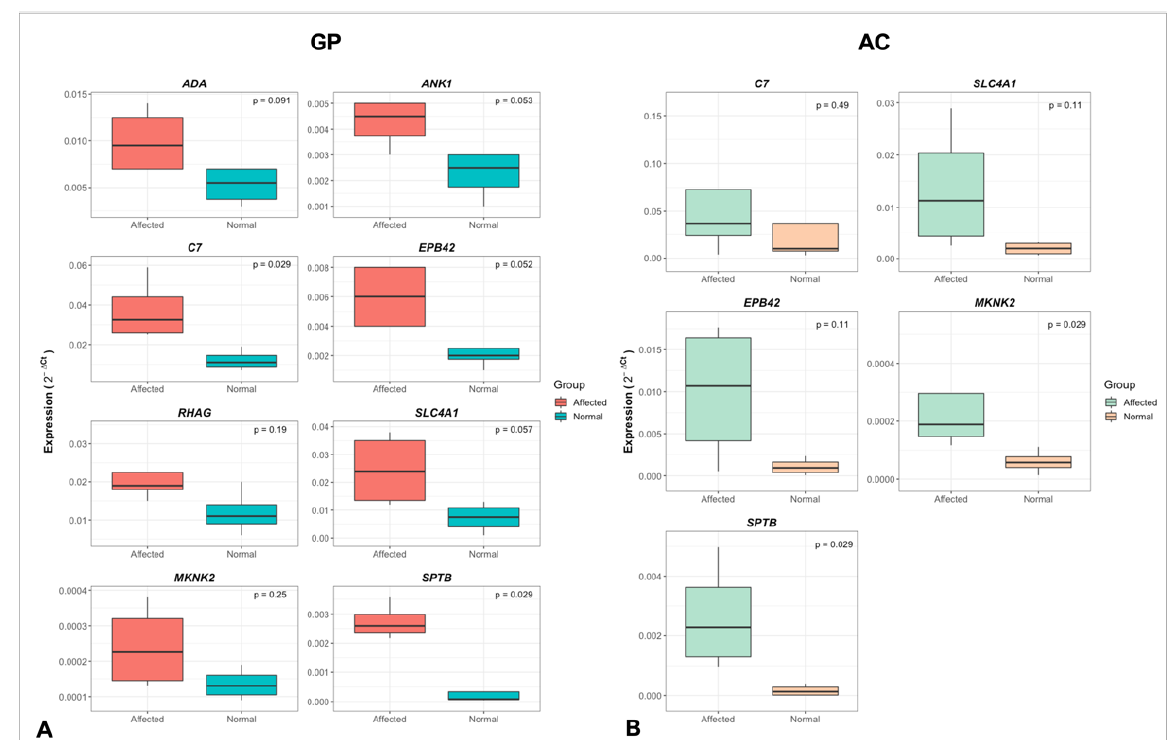
Figure 5. Expression profile (2 −ΔCt ) and statistical significance between normal and FHS-affected broilers obtained with qPCR for GP ( A ) and AC ( B ) for the candidate genes evaluated.